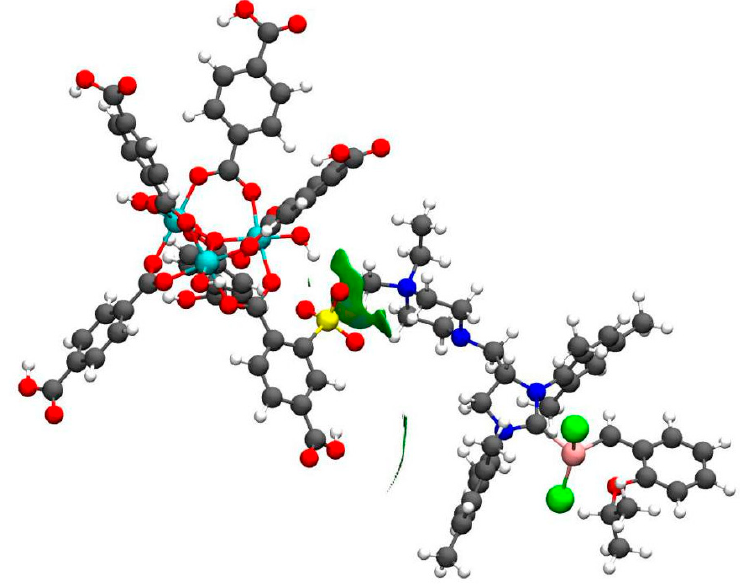
Figure 6. NCI plot of the truncated MOF in combination with Precat.